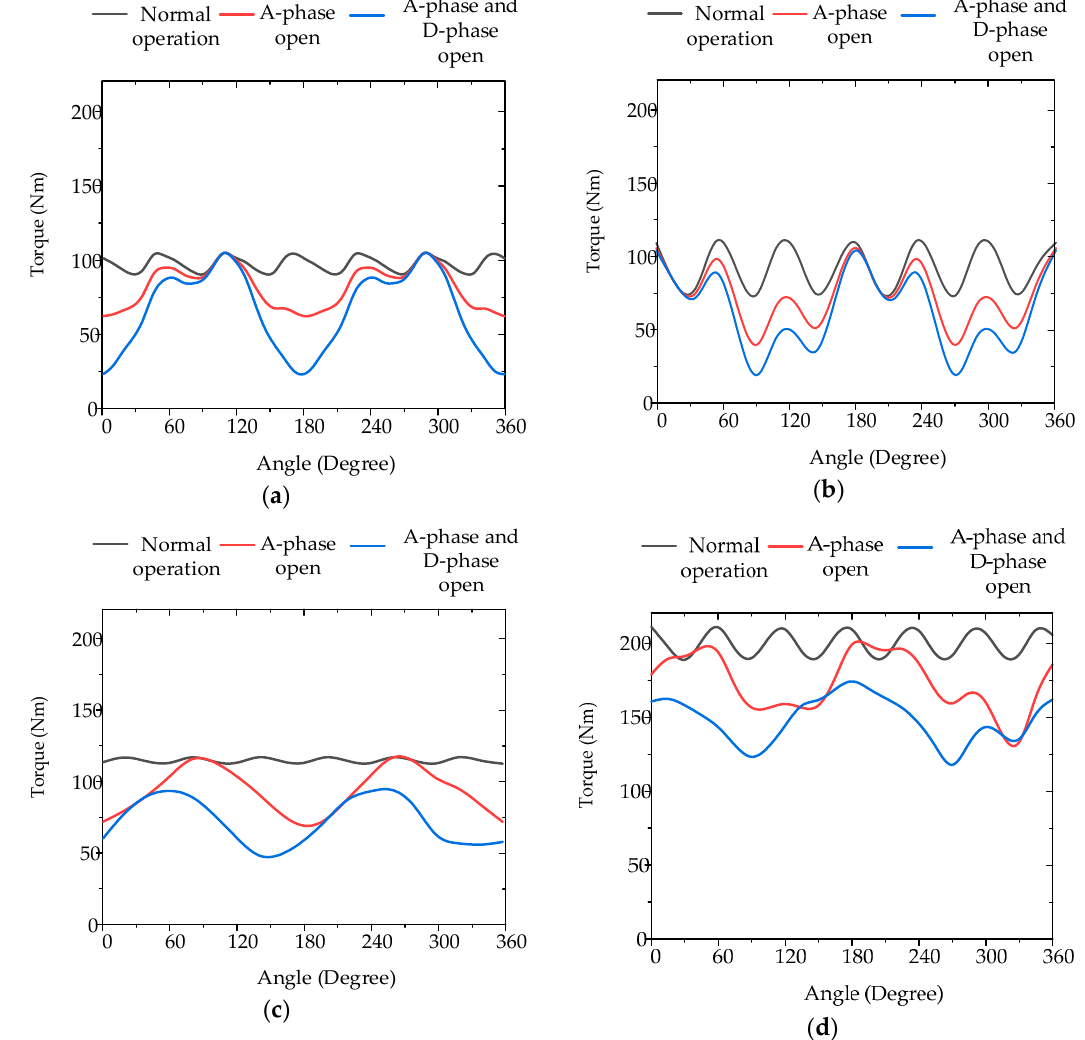
Figure 11. Torque at open-phase fault of proposed six-phase outer-rotor PM machines: ( a ) IPM type; ( b ) SPM type; ( c ) PMFS type; ( d ) PMV type.